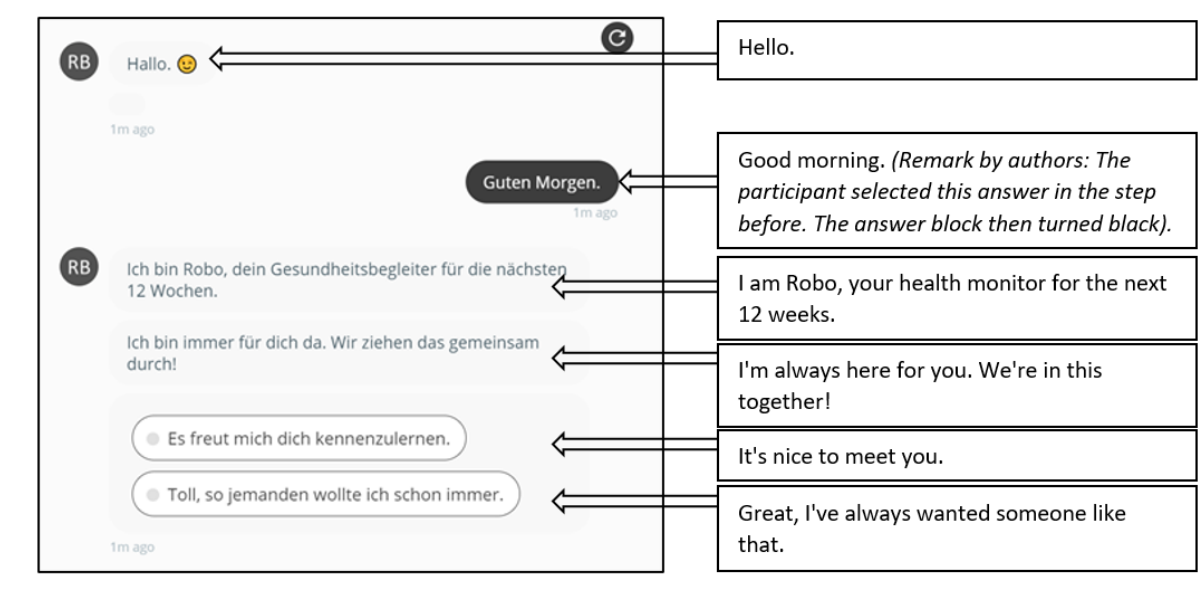
Figure 5. An exemplary conversation snapshot between the conversational agent Robo and a participant. This figure depicts the start of the interaction, here applying the deliberative interaction style. The interaction was conducted in German; the authors added the English translations in the callouts for this